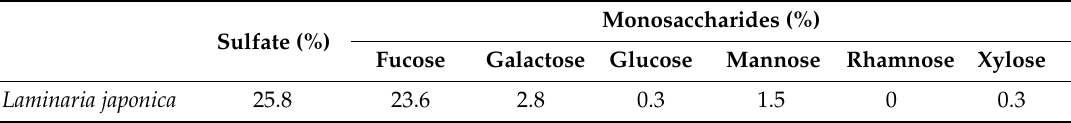
Table 2. Chemical compositions of the fucoidan from Laminaria japonica . Sulfate (%) Fucose Galactose Glucose